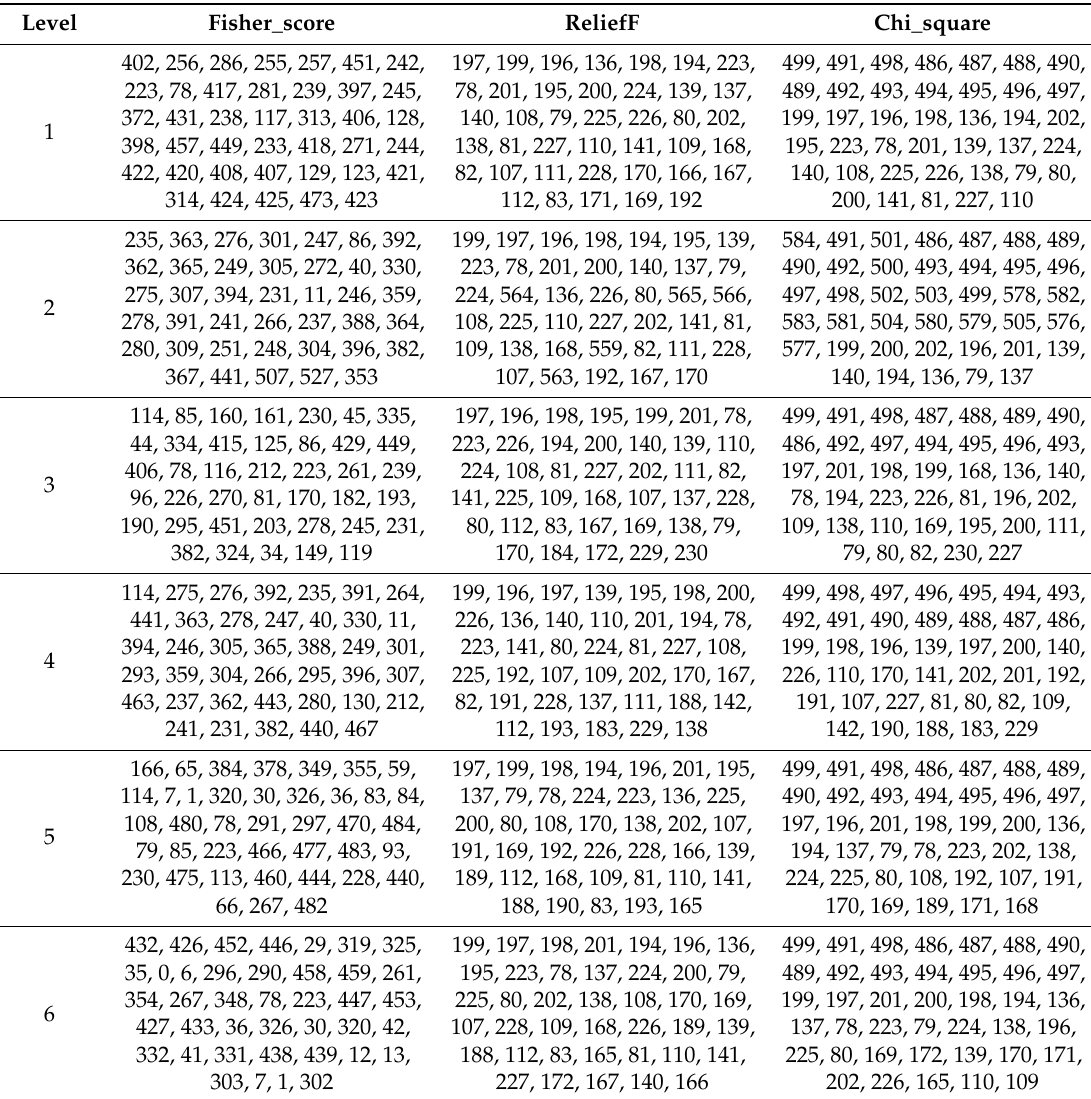
Table 7. The feature numbers of classification for the five layers using three feature selection algorithms.